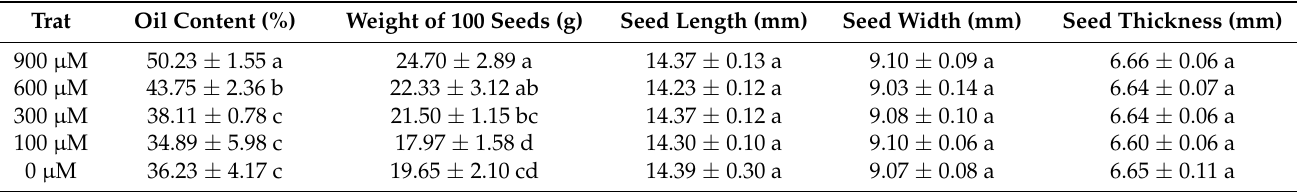
Table 2. Oil content, weight of 100 seeds and morphological characteristics of castor seeds of plants treated with salicylic acid.